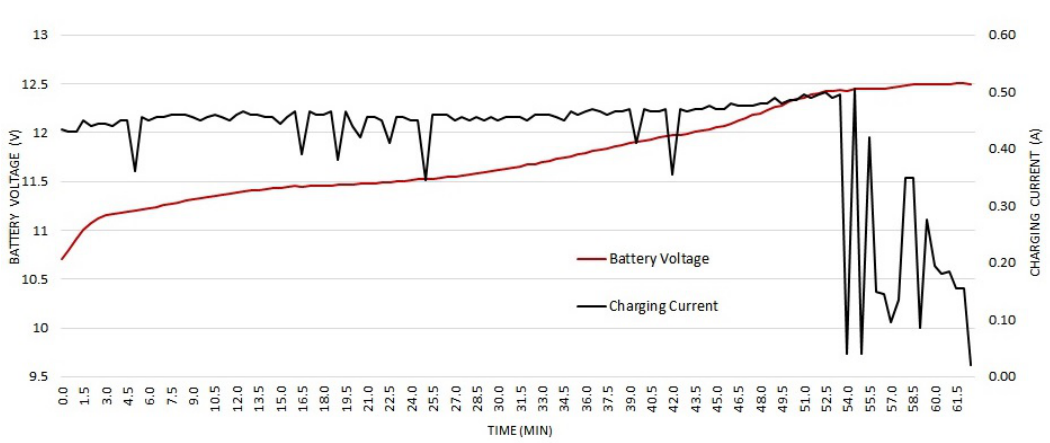
Figure 13. Battery voltage and charging current during